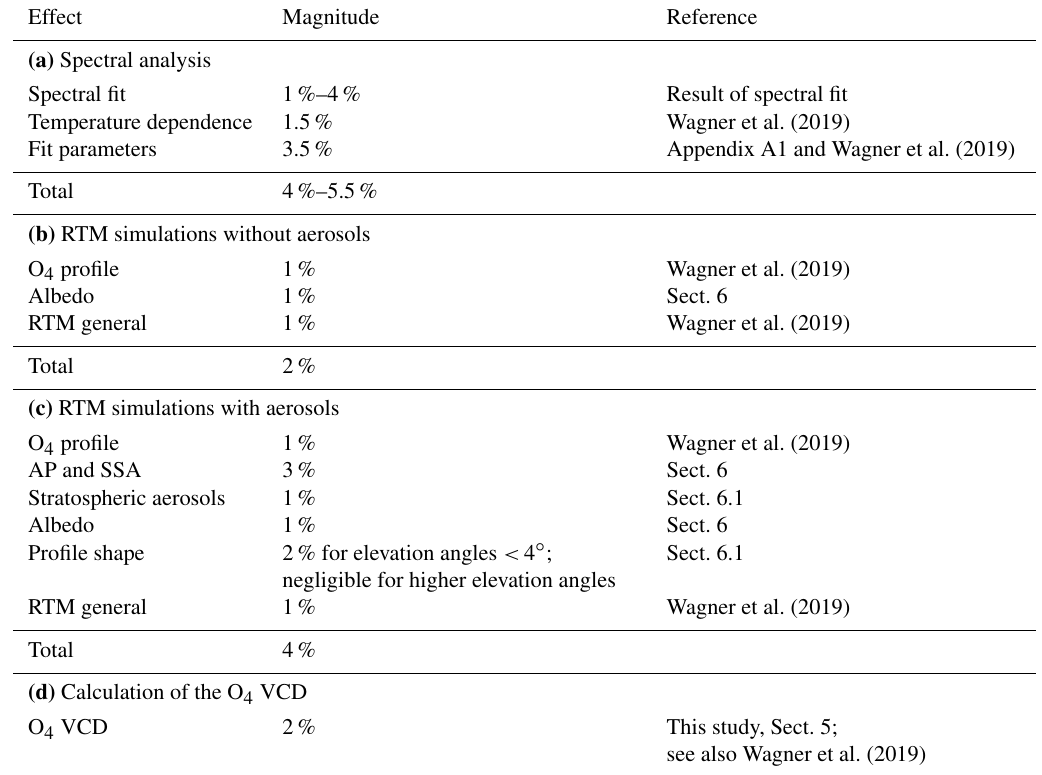
Table 3. (a) Uncertainties related to spectral analysis. (b) Uncertainties related to RTM simulations without aerosols. (c) Uncertainties related to RTM simulations with aerosols. AP indicates the asymmetry parameter and SSA indicates single scattering albedo. (d) Uncertainties related to calculation of the O 4